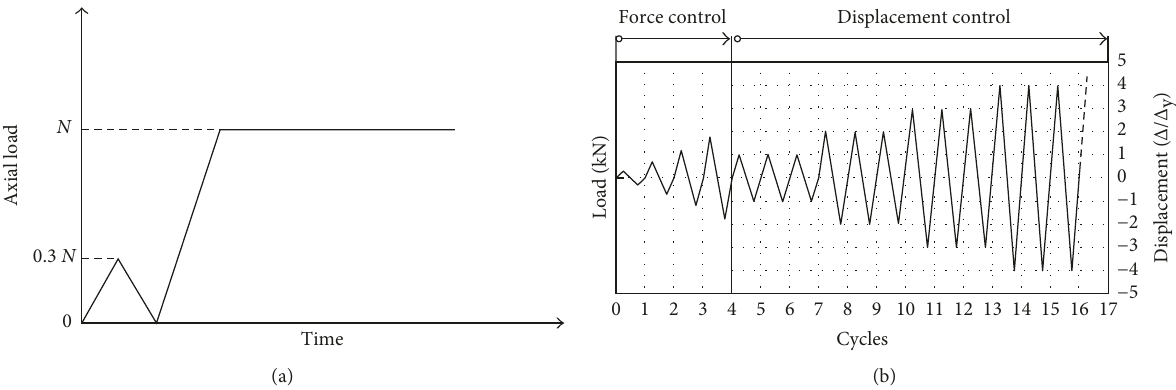
Figure 4: The schematic view of loading history. (a) Loading procedure of column end. (b) Loading procedure of beam